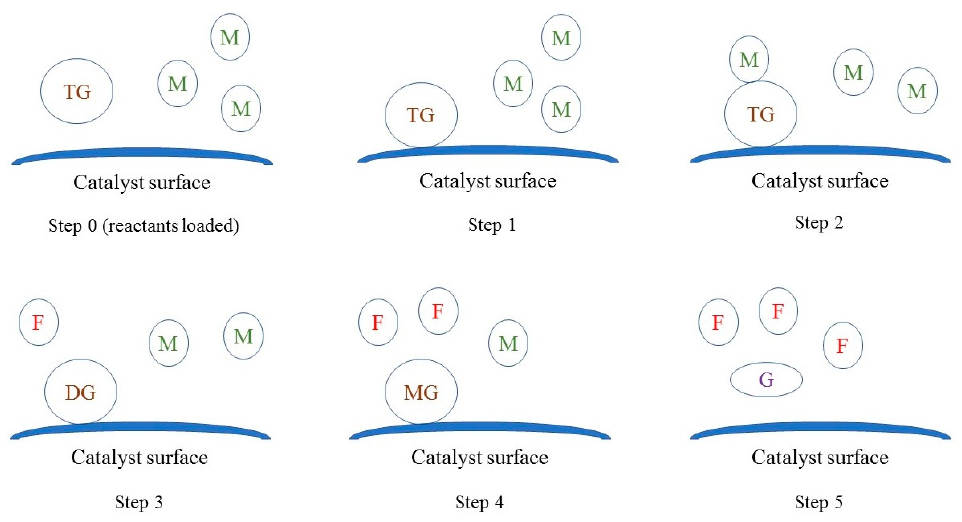
Figure 11. The mechanism of Na-COS-catalyzed transesterification of soybean oil with methanol. TG, DG, MG, M, G, F represent triglyceride, diglyceride, monoglyceride, methanol, glycerol, and FAME, respectively.